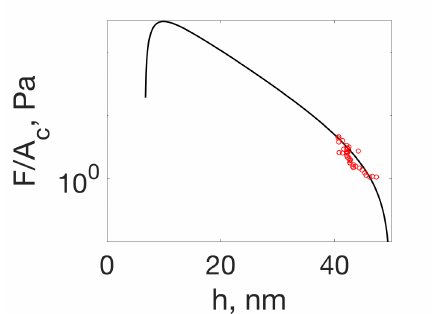
Figure 8. Disjoining pressure of silica on calcite interface in saturated CaCO 3 solution calculated from DLVO theory (whole drawn line) and contact pressures versus fluid film thickness, h , calculated from experimental interference intensities for Crystal